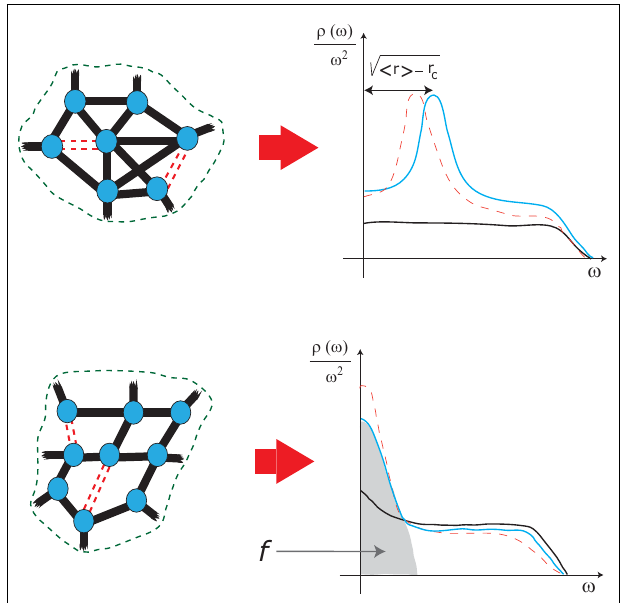
FIGURE 1 | Evolution of the reduced density of states for a diluted bond network, starting from an over-constrained network (upper network) and from an isostatic lattice (lower network) . The dotted lines indicate diluted bonds, while solid bars indicate intact bonds. The position of √ < r > − r c . For the isostatic lattice, < r > = r c the Boson peak evolves as and the Boson peak has zero frequency, i.e., it becomes a floppy mode. As dilution continues, the floppy peak, indicated by an f , has an increasing